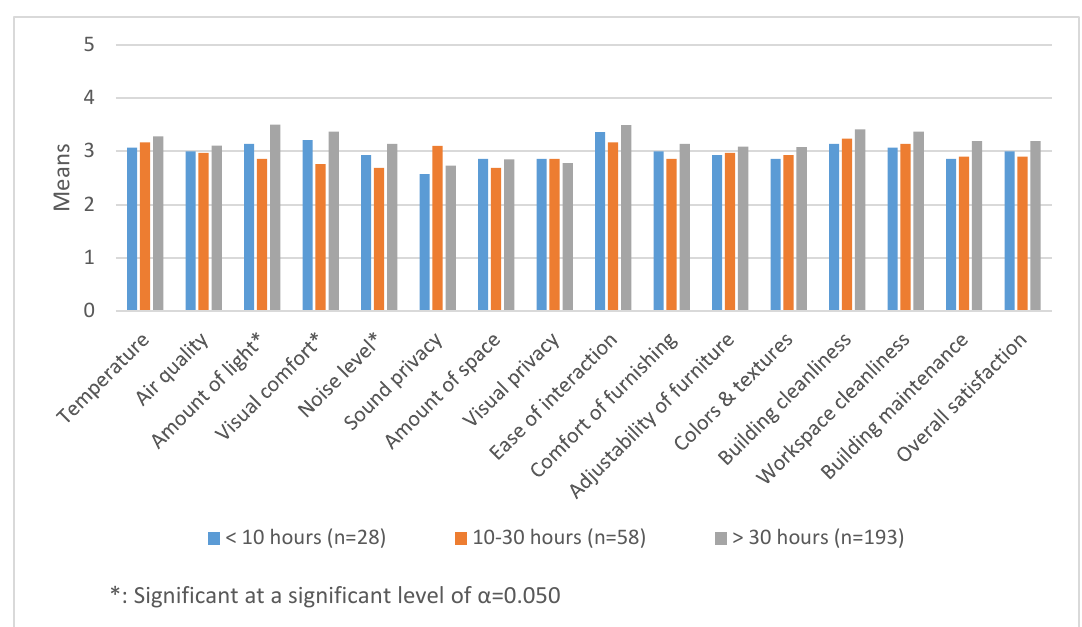
Figure 7. The impact of time spent at work on satisfaction with IEQ factors.